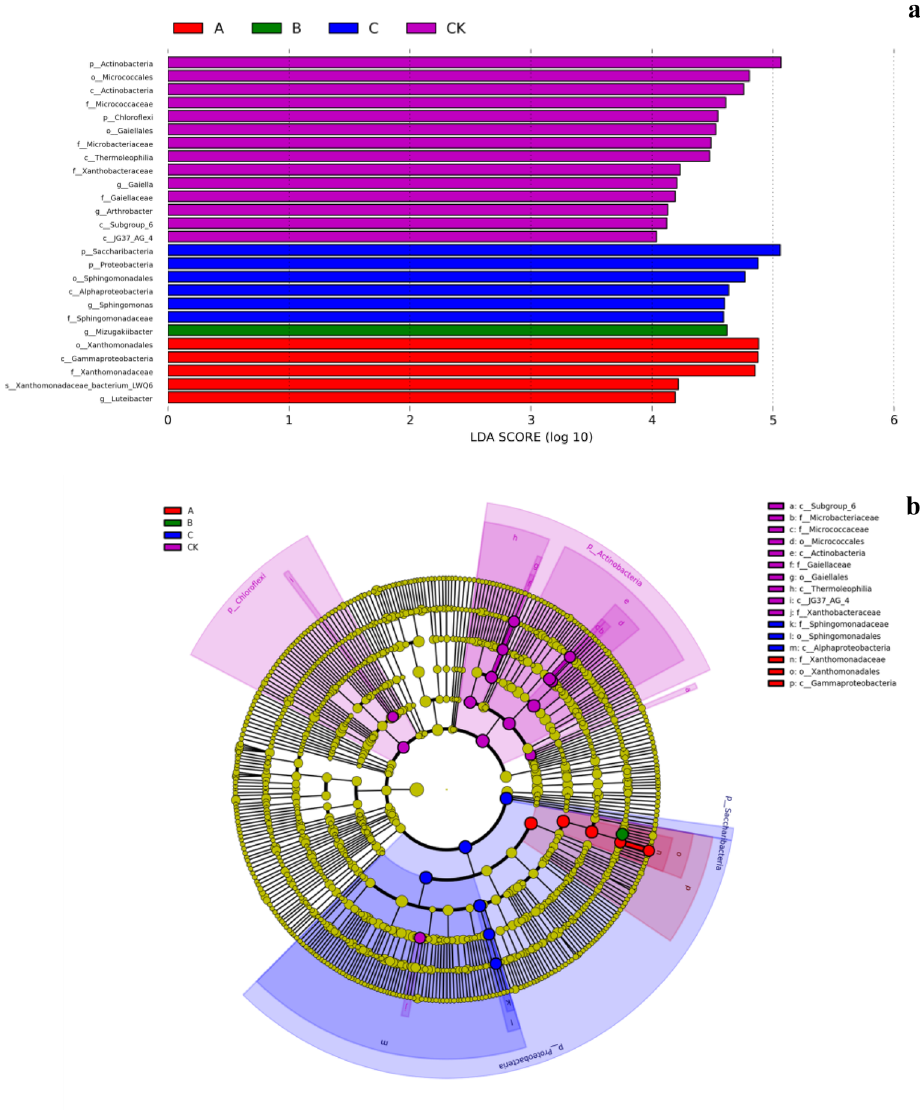
Figure 7. Classification level discriminant analysis (LDA) ( a ) and class level LEfSe analysis ( b ). Using LEfSe1.1.0 software (http:// hutte nhower. sph. harva rd. edu/ lefse) to create. ( a ) shows the biomarker with statistical difference for the taxa with LDA score greater than the set value. The default value is 4.0 (see the abscissa, only the absolute values of LDA greater than 4 are shown in the figure). The color of the bar chart represents each group, and the length of the bar chart represents the size of the LDA score, which represents the impact size of the taxa with significant differences. ( b ) the circles radiating from the inside to the outside represent taxonomic levels from phylum to genus (or taxa). Each small circle at different taxonomic levels represents a taxon at that level, and the diameter of the small circle is positively correlated with the relative abundance. Color: taxa with no significant difference are uniformly colored in yellow, and the biomarker taxa are colored according to the group. The red nodes represent the taxa with significant differences in the red group, and the green nodes represent the taxa with significant differences in the green